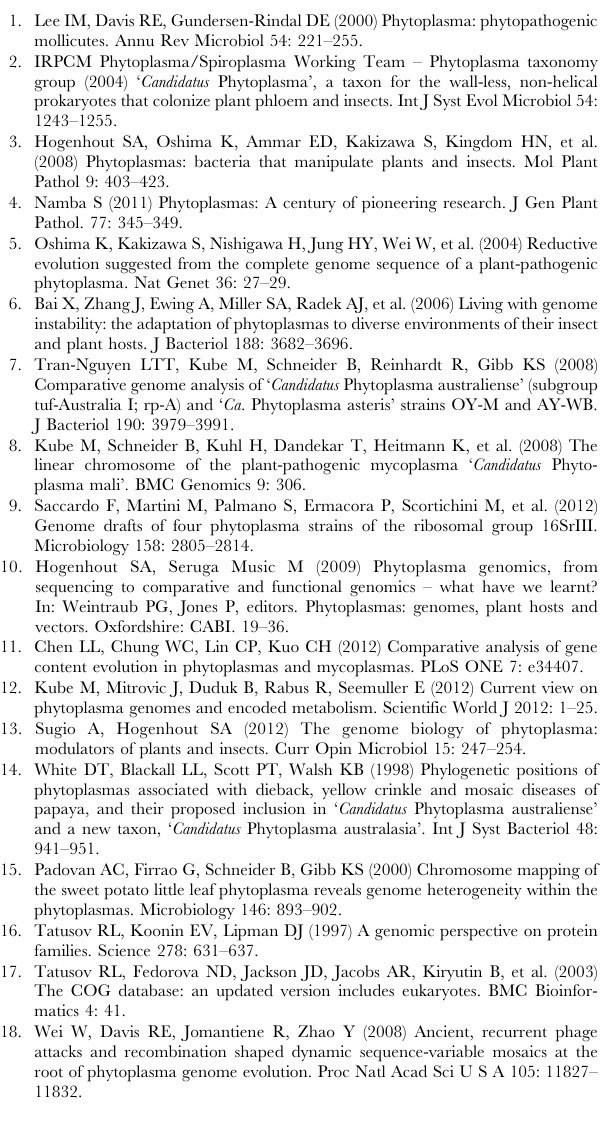
Table S1 Summary of protein-coding gene repertoire by functional categories. Summary of protein-coding gene repertoire in the five available phytoplasma genomes by functional categories. The table format is adopted from Kube et al. [12]. Table S2 List of homologous gene clusters. List of homologous gene clusters in the five available phytoplasma genomes. Table S3 List of putative effectors. List of putative effectors in the five available phytoplasma genomes. Table S4 List of PMU-associated genes. List of PMU-associated genes in the five available phytoplasma genomes.